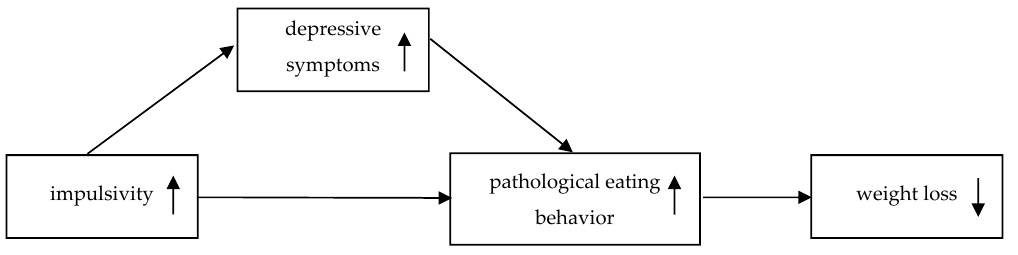
Figure 1. Theoretical model of the relation between impulsivity and weight loss outcome after bariatric surgery.